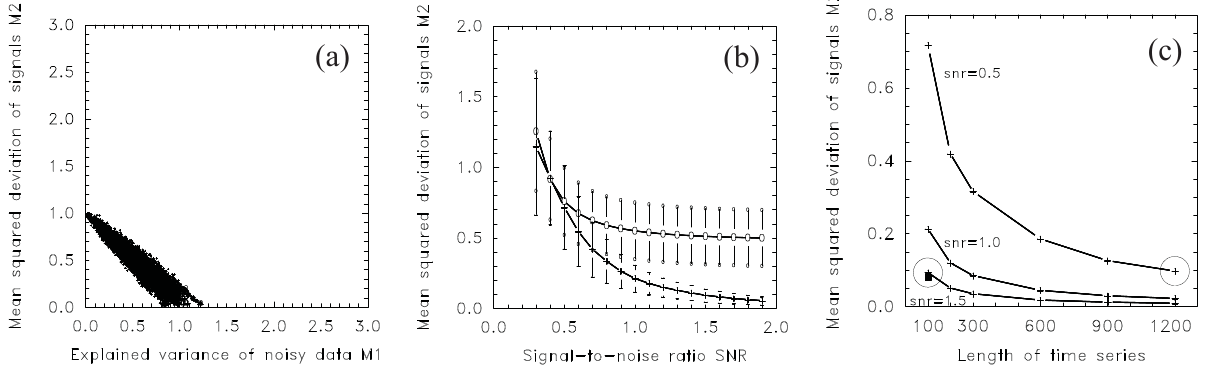
Figure 13. (a) Mean squared signal deviation (M2) against explained variance of the noisy data (M1) for 100 random segmentations of 100 simulated time series with length 100, including seven true breaks and tested by the same number of breaks. As Fig. 11b, but for SNR = 2. (b) Mean squared deviation between true and estimated break signal M2 for simulated time series of length 100, including seven breaks averaged over 1000 repetitions. Skill M2 is given as a function of the signal-to-noise ratio for two cases: search method (crosses) and random segmentation (circles). The standard deviations for both cases are given as whiskers. (c) Mean squared deviation of signals M2 as a function of series length for three different SNRs (0.5, 1.0, and 1.5). The mean deviation M2 of each length class and SNR is obtained by 1000 repetitions. Two specific values (SNR = 1 . 5, n = 100) and (SNR = 0 . 5, n = 1200) are marked by circles and discussed in the text, as well as the filled square denoting data which are directly averaged from n = 1200 to n = 100 for SNR = 0 .